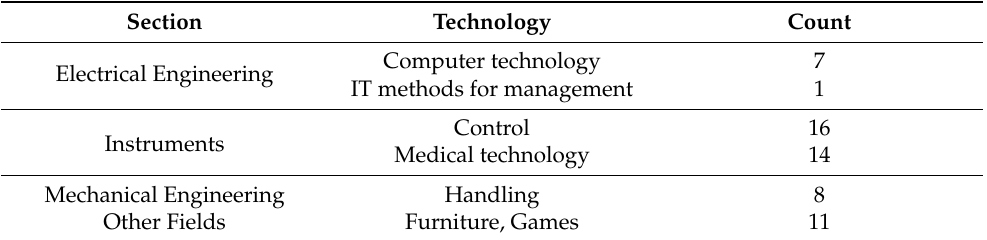
Table 9. Classification of patent samples in the different sections and technological areas.